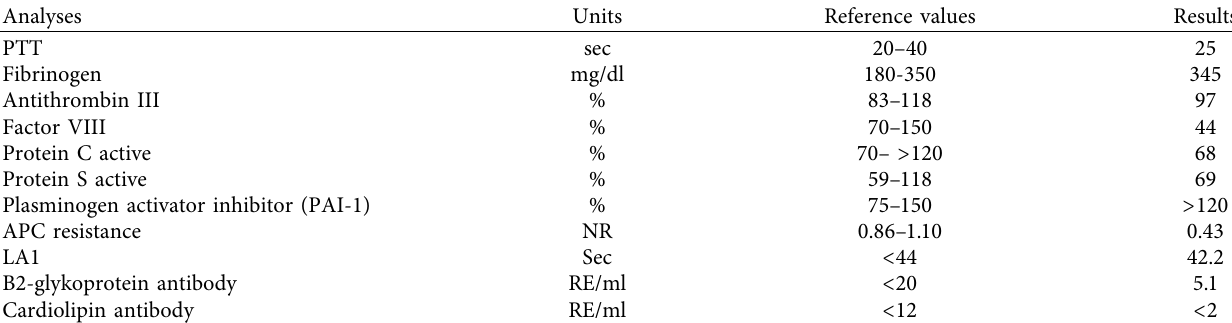
Table 1: Results of thrombophilia testing in the reported